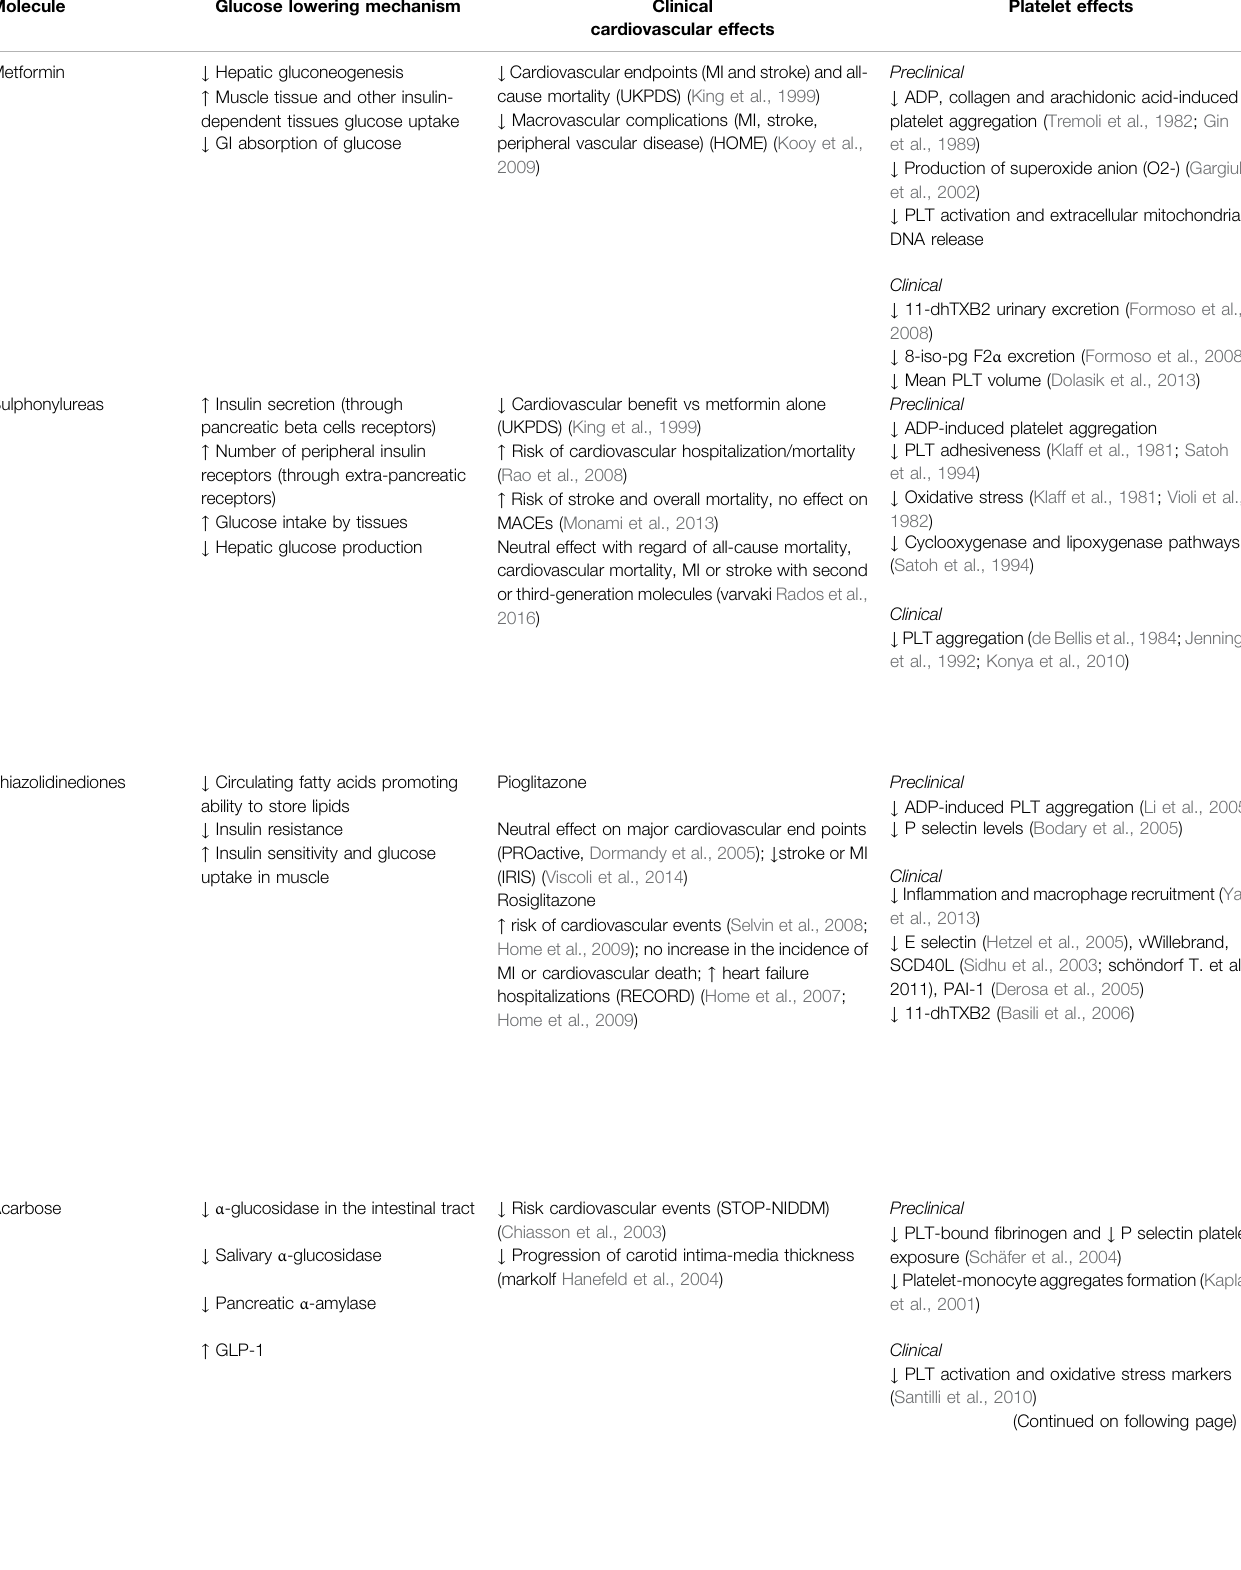
TABLE 1 | Cardiovascular and platelet effects of anti-diabetic